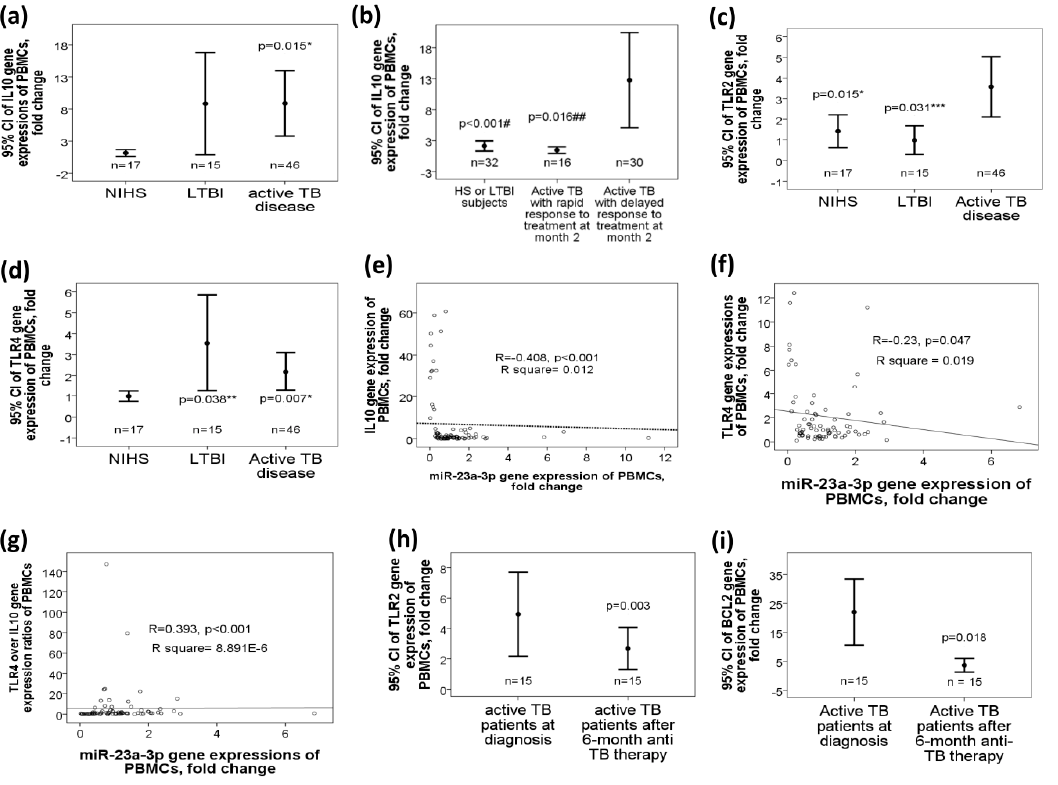
Figure 3. Di ff erential gene expressions of the predicted target genes of miR-23a-3p in TB patients, and the e ff ect of miR-23a-3p mimic transfection on macrophage functions. Interleukin (IL) 10 gene expression was increased in ( a ) active TB patients versus NIHS, and further increased in that of ( b ) those with delayed response to 2-month anti-TB therapy versus those with rapid response or the control group (LTBI + NIHS). ( c ) TLR2 gene expression was increased in active TB versus either the LTBI or NIHS group. ( d ) TLR4 gene expression was increased both in active TB and LTBI groups versus NIHS. MiR-23a-3p gene expression was negatively correlated with ( e ) IL10 and ( f ) TLR4 gene expressions, and ( g ) positively correlated with TLR4 / IL10 gene expression ratios. Both ( h ) TLR2 and ( i ) BCL2 gene expressions were reduced after 6-month anti-TB therapy. * p < 0.05, compared between active TB patients and NIHS (adjusted by linear regression analysis model) ** p < 0.05, compared between LTBI and NIHS (adjusted by linear regression analysis model) *** p < 0.05, compared between active TB patients and LTBI (adjusted by linear regression analysis model) # p < 0.05, compared between NIHS and active TB patients with delayed response (adjusted by linear regression analysis model) ## p < 0.05, compared between active TB patients with delayed response and those with rapid response (adjusted by linear regression analysis model) In the 15 active TB patients with second blood sampling, TLR2 (2.18 ± 1.94 versus 4.87 ± 4.06 fold change, p = 0.003, Figure 3h) and BCL2 (1 ± 1.19 versus 3.65 ± 4.05 fold change, p = 0.018, Figure 3i) gene expressions were both reduced after 6-month anti-TB therapy as compared with that before